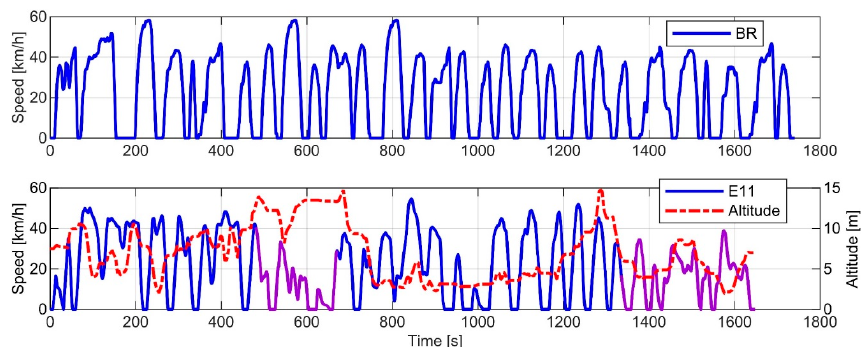
Figure 4. Comparison between Braunschweig (BR) and Espoo 11 (E11), purple sections in the E11 cycle indicate areas with high density urban dwellings.